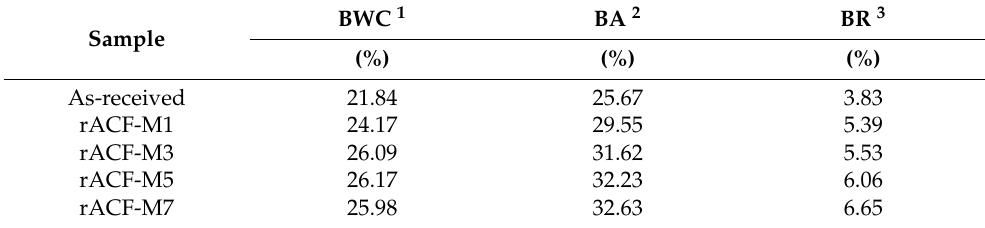
Figure 5. Five repeated butane adsorption and desorption measurements of activated carbon fibers as a function of the microwave heating time. Table 3. Butane Adsorption/Desorption Behaviors of Activated Carbon Fibers according to the Microwave Heating